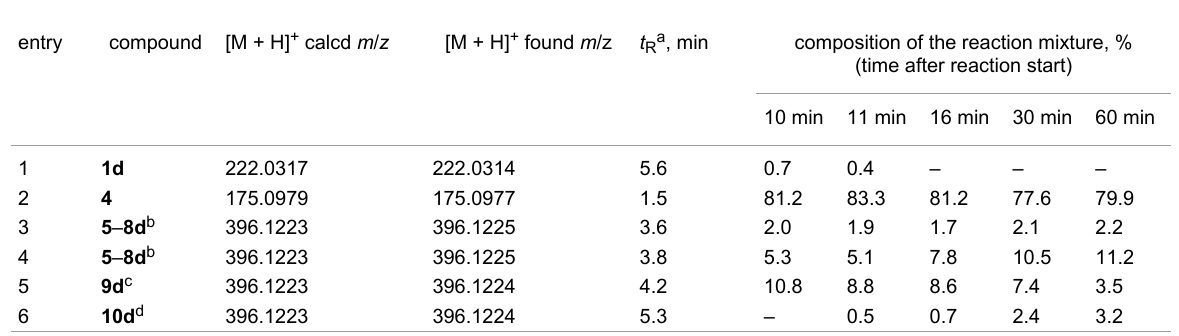
Table 2: Results of HPLC–HRESIMS monitoring of the reaction mixture composition in the synthesis of imidazopyridazine 9d .